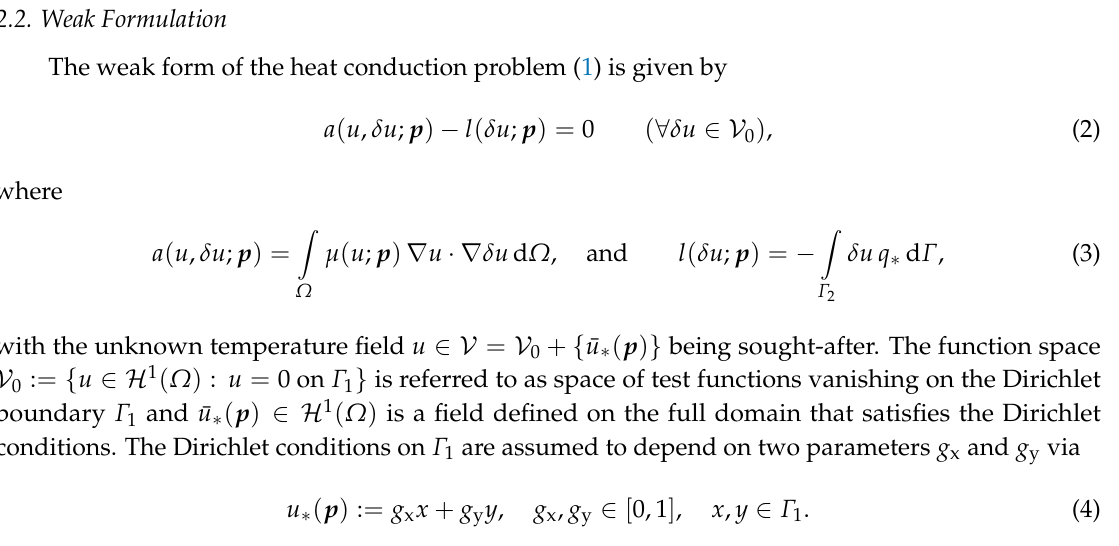
Figure 1. Geometry of the planar benchmark problem ( left ) and nonlinearity of the temperature dependent conductivity µ ( right